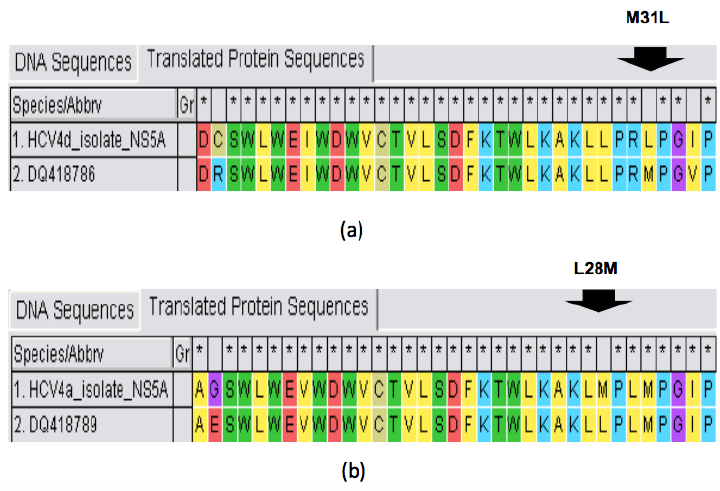
Figure 2. RASs in the HCV4d ( a ) and HCV4a ( b ) NS5A target region vs. subtype reference sequence visualized by MEGAv7 software.